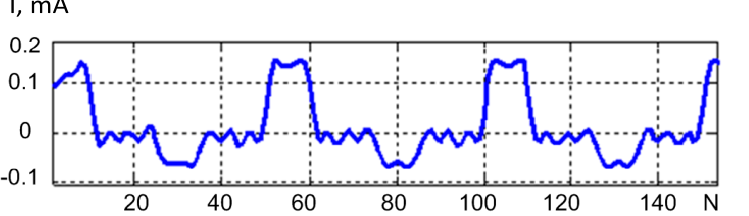
Figure 12. Noise suppression using a 9th order Butterworth filter with a cutoff frequency of 330 kHz. The Type I Chebyshev filter of the 9th order with the cutoff frequency of 330 kHz allowed achieving SNR = − 6 dB (see Figure 13).